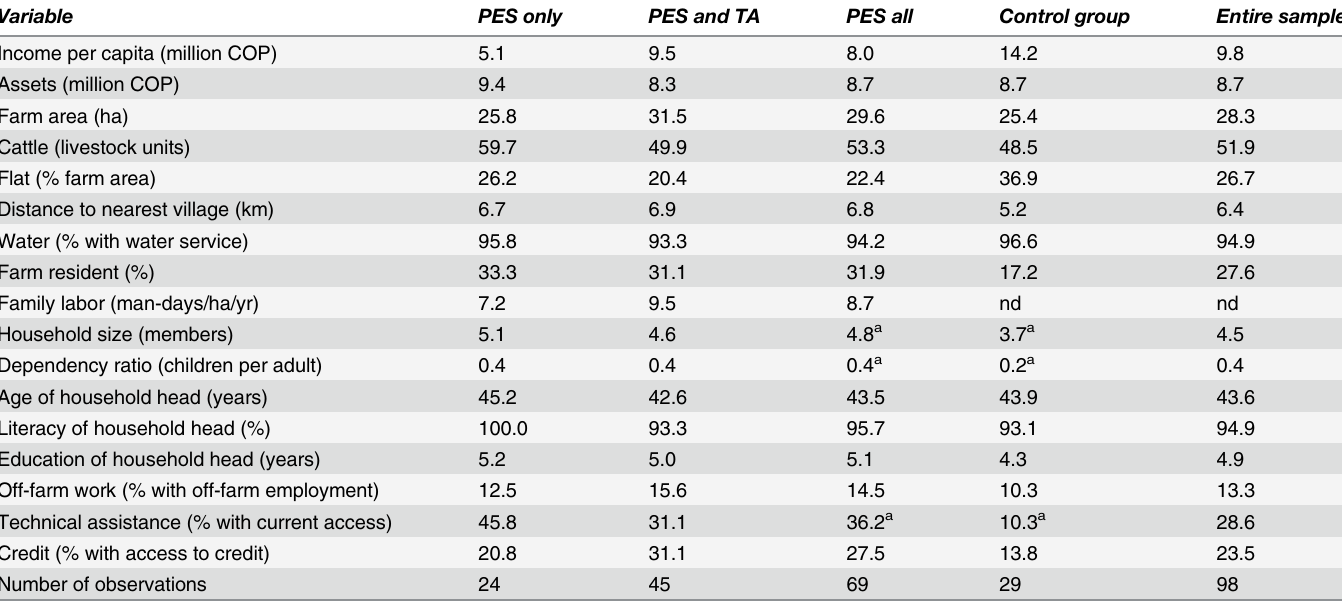
Table 2. Characteristics of participating households, Quindío,